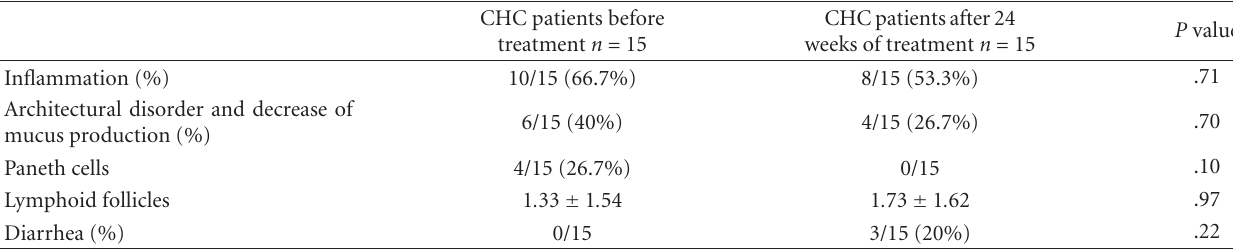
Table 2: Comparison of large intestine histopathology and diarrhea data of CHC patients before and after 24 weeks of treatment.